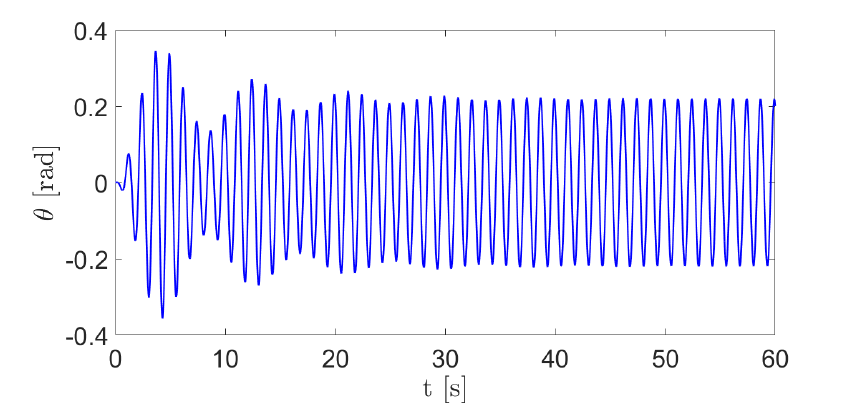
Figure 7. Dynamic response of the primary system with pendulum absorber (Tuned Mass Damper case).